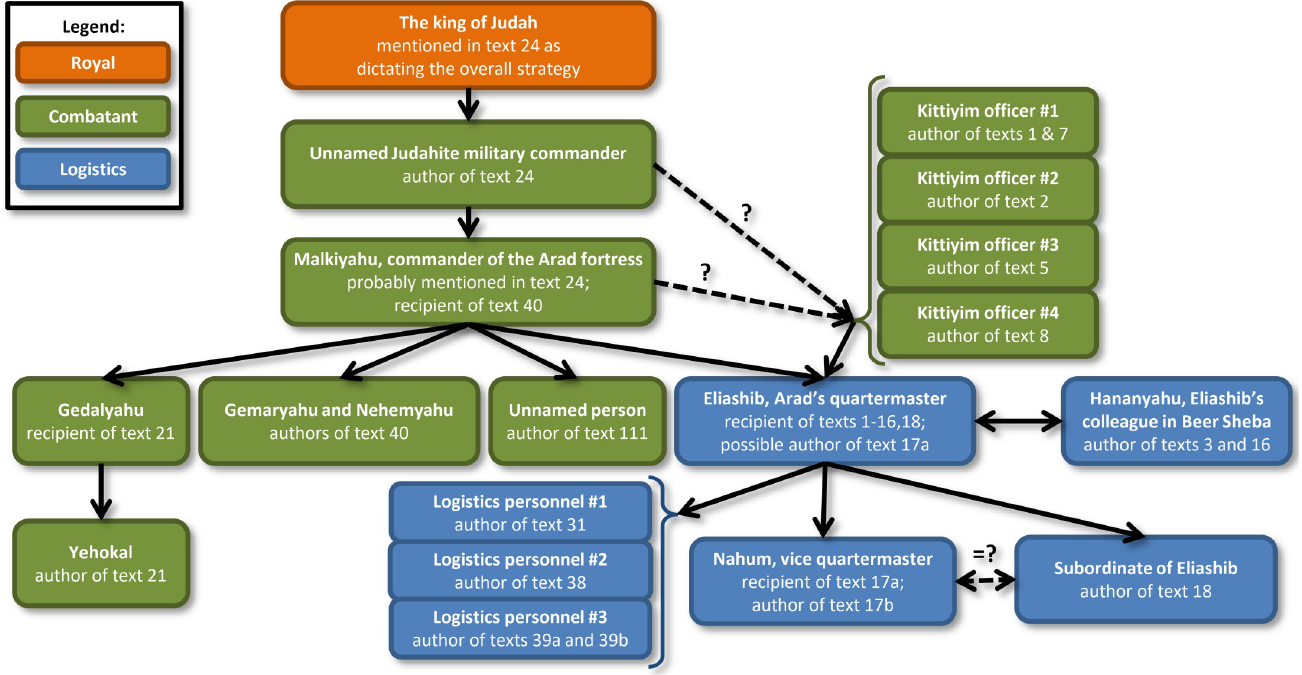
Fig 6. Possible reconstruction of relations between Arad inscriptions and different writers according to the forensic analysis. Differentiation between combatant and logistics officials is also indicated.